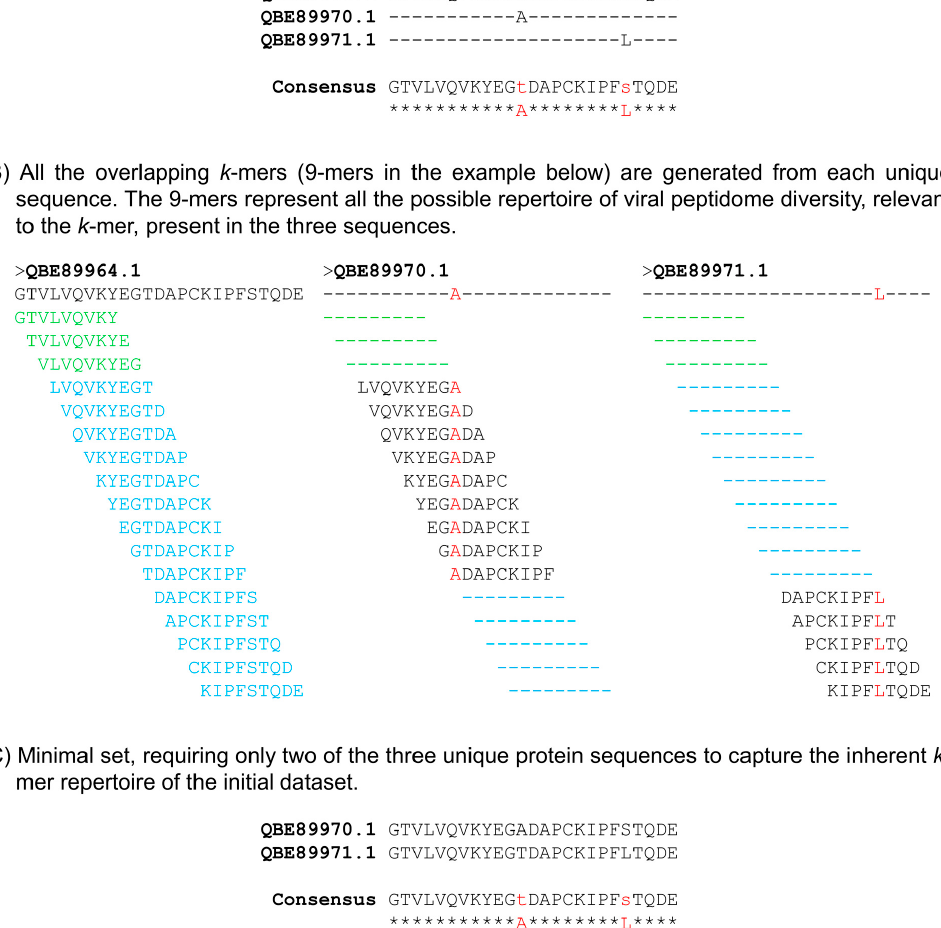
Figure 1. Definition of a minimal set. ( A ) Three unique dengue virus envelope protein sequences (QBE89964.1, QBE89970.1, and QBE89971.1) retrieved from the NCBI Entrez Protein Database are shown aligned (only a 25 amino acids fragment is shown for demonstration purposes). The consensus of the alignment is shown, with positions of variability indicated by the small case residues (variable amino acids A and L colored in red). ( B ) All the overlapping k -mers (9-mers in this example) are generated from each unique sequence. The 9-mers represent all the possible repertoire of viral peptidome diversity, relevant to the k -mer, present in the three sequences. Although these three sequences are each unique, they share identical 9-mers. The 9-mers shown in green color are those that are identical in all the three sequences, while those in cyan are identical between two of the sequences. The unique 9 ‐ mers are shown in black color with variable resi ‐ dues indicated in red. All the 9 ‐ mers in sequence QBE89964.1 have a match in at least one of the other two sequences; thus, the k ‐ mer repertoire of this sequence can be collectively covered by the other two sequences, rendering the sequence QBE89964.1 as redundant. ( C ) Minimal set, requiring only two of the three unique protein sequences (QBE89970.1 and QBE89971.1) to capture the inherent k ‐ mer repertoire of all the unique sequences in the initial dataset.